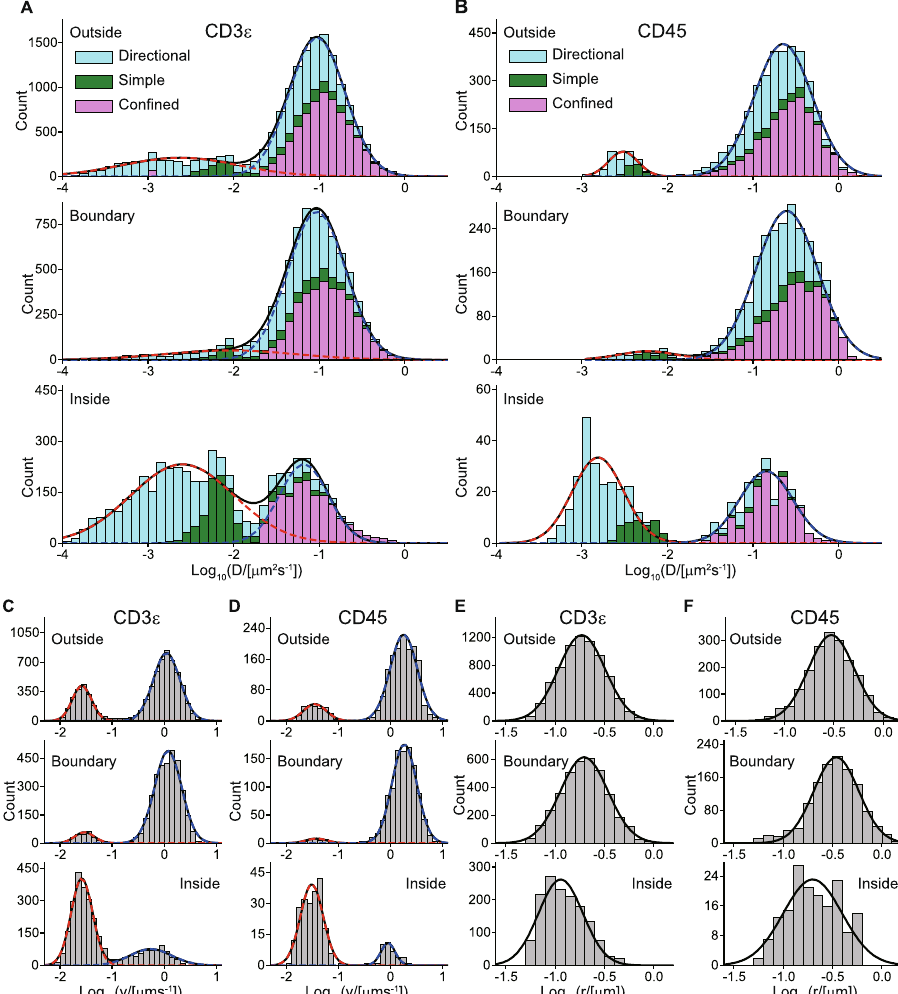
Figure 5. Two mobility states and their properties for CD3 ε and CD45 revealed by moving subtrajectory analysis. ( A,B ) Distributions of log 10 ( D/ [ μ m 2 /s]) on the inside, at the boundary, and on the outside of the microclusters obtained by moving subtrajectory analysis. The three diffusion types are shown as follows: simple (green), directional (cyan), and confined (magenta). The histograms of overall distributions, which were the total of the three diffusion types, were fitted by the dual normal distribution corresponding to the two-state diffusion model (Equation 9, black line) composed of the slower (red dashed line) and faster (blue dashed line) mobility states. The distributions separated into the three diffusion types were also well fitted by the dual normal distribution (Table S4)), ( C , D ) Distributions of log 10 ( v direc / [ μ m/s]), where v direc is the velocity of the directional movement of the directional diffusion mode (Equation 6). The histograms were fitted by the dual normal distribution (black line), composed of the slower (red dashed line) and faster (blue dashed line) components. ( E,F ) Distributions of log 10 ( r conf / [ μ m]), where r conf is the confinement radius of the confined diffusion mode (Equations 7 and 8). The histograms were fitted by the normal distribution (black